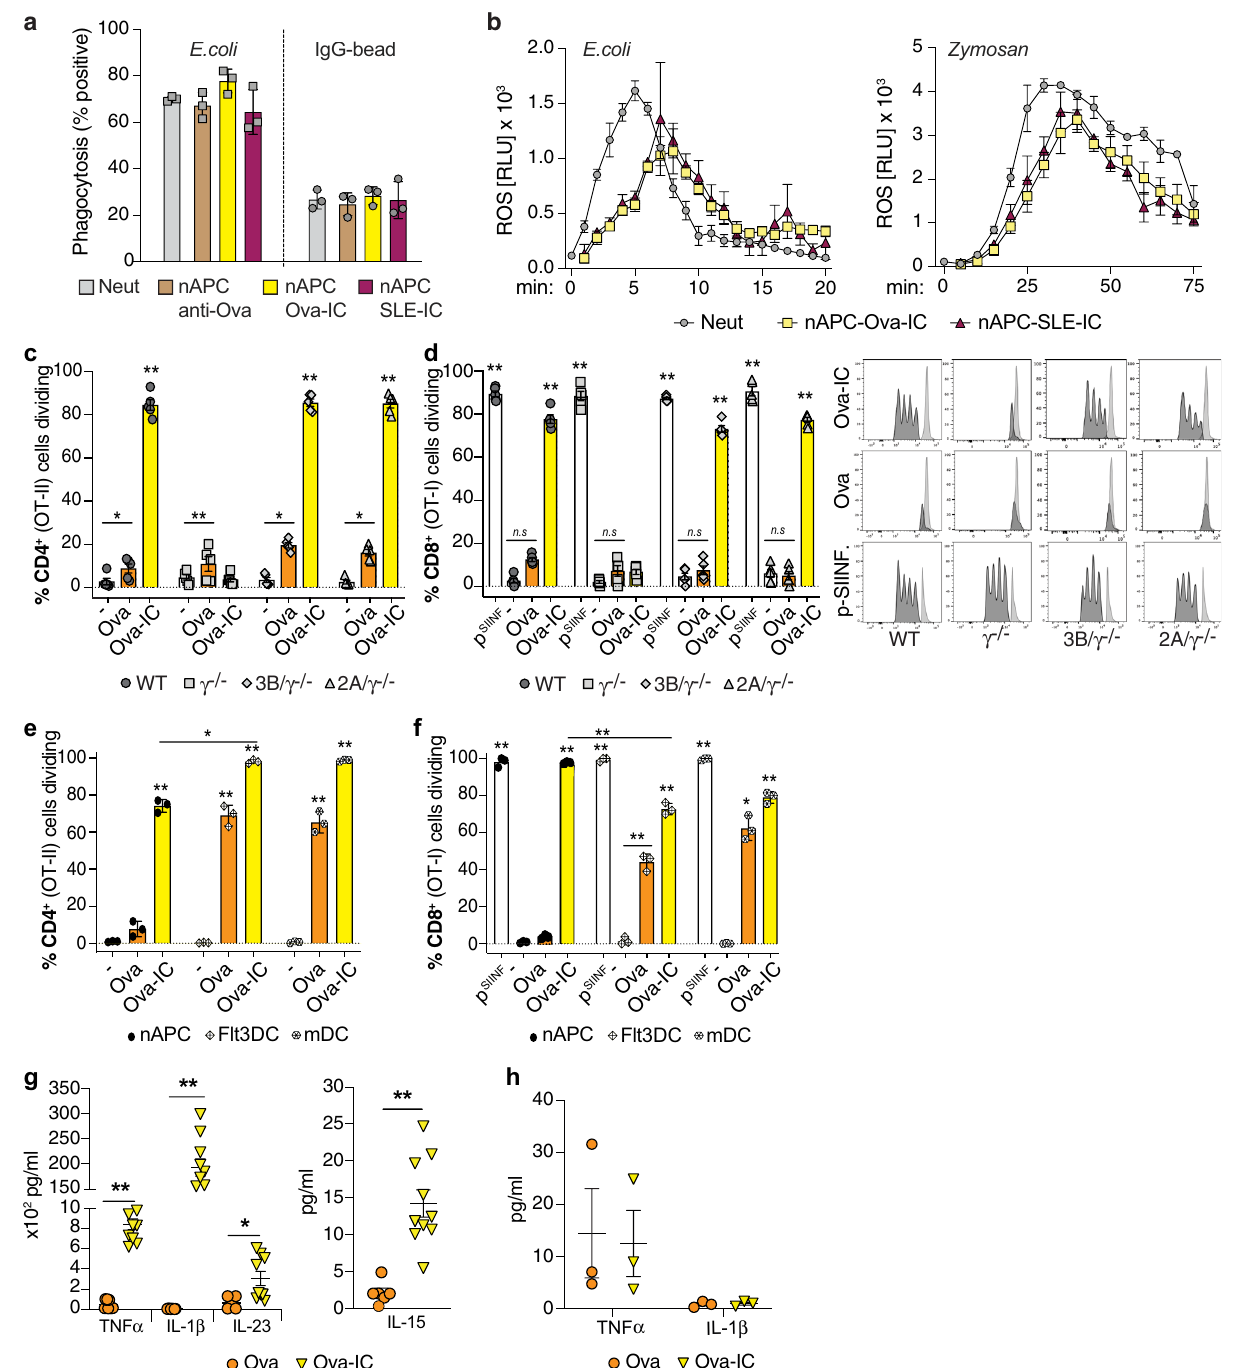
Fig. 3 Ova-IC generated nAPCs retain neutrophil functions, promote naive CD4 + and CD8 + T cell proliferation and generate immunogenic cytokines. a Freshly isolated FcgRIIIB(3B)/ γ − / − BMNs (Neut) or the same treated with anti-Ova, Ova-IC or SLE-IC and cultured to generate nAPCs were incubated with inactivated FITC- E. coli or IgG-coated, FITC-labeled latex beads and analyzed for FITC-uptake by fl ow cytometry. b Reactive oxygen species (expressed as relative light units/sec, RLU/s) generated over time by GM-CSF-primed 3B/ γ − / − Neut and Ova-IC- or SLE-IC- generated nAPCs incubated with serum opsonized E. coli or zymosan. c , d Proliferation of CellTrace Violet-labeled CD4 + (OT-II) ( c ) and CD8 + (OT-I) ( d ) T cells after co-culture with Ova, Ova-IC or vehicle ( − , GM-CSF alone) generated nAPCs of indicated genotypes assessed by CellTrace Violet dilution. In d , vehicle generated nAPCs pulsed with Ova SIINFEKL-peptide (pSIINF) is a positive control. Representative pro fi les for CD8 + T cells ( d ) are shown. e , f CellTrace Violet-labeled CD4 + ( e ) or CD8 + ( f ) T cells co-cultured with Ova- or Ova-IC generated nAPC, and Ova or Ova-IC treated splenic monocyte-derived (mDC) or Flt3L-induced splenic DCs, and analyzed as in ( c , d ). g , h Cytokine concentrations in supernatant of Ova- and Ova-IC generated nAPCs ( g ) and splenic cDCs ( h ). Data are mean ±s.e.m. For c – f one-way analysis of variance and Dunnett ’ s multiple comparison test; g , h Multiple t test between pairs of samples. * p < 0.05, ** p < 0.005.